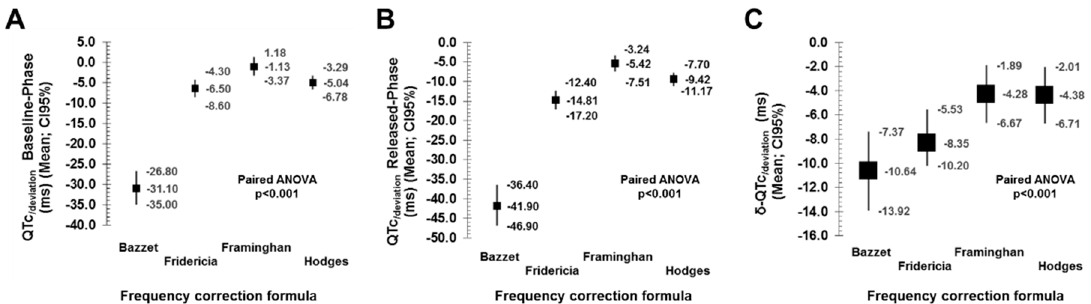
Figure 5. Comparative performance of the QTc / deviation . See text for discussion.